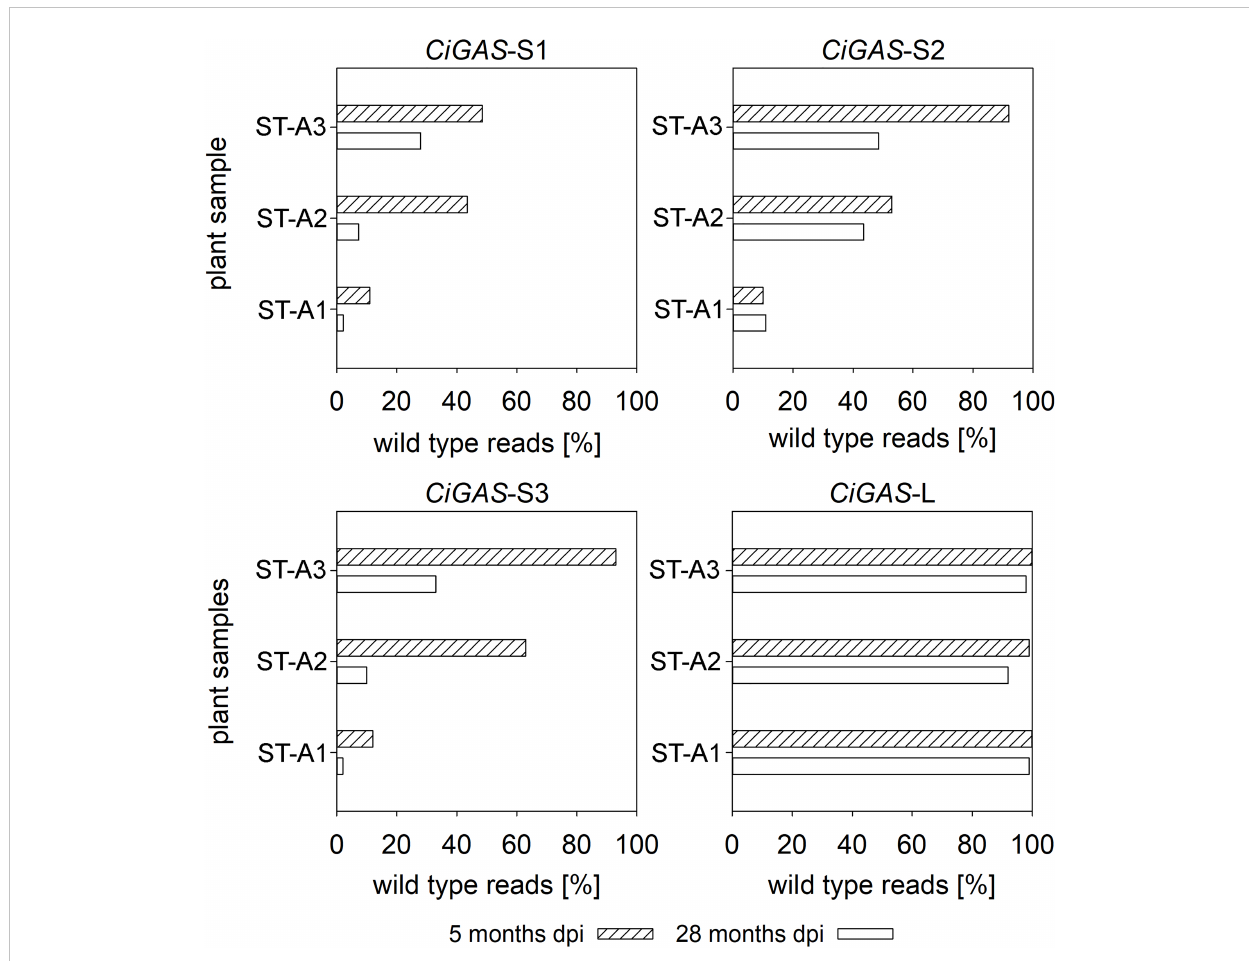
FIGURE 3 Change of wild type reads in transgenic chicory plants over two years. DNA was isolated fi ve months and 28 months after transformation. All three plants show a decrease in their percentage of wild type sequences in NGS